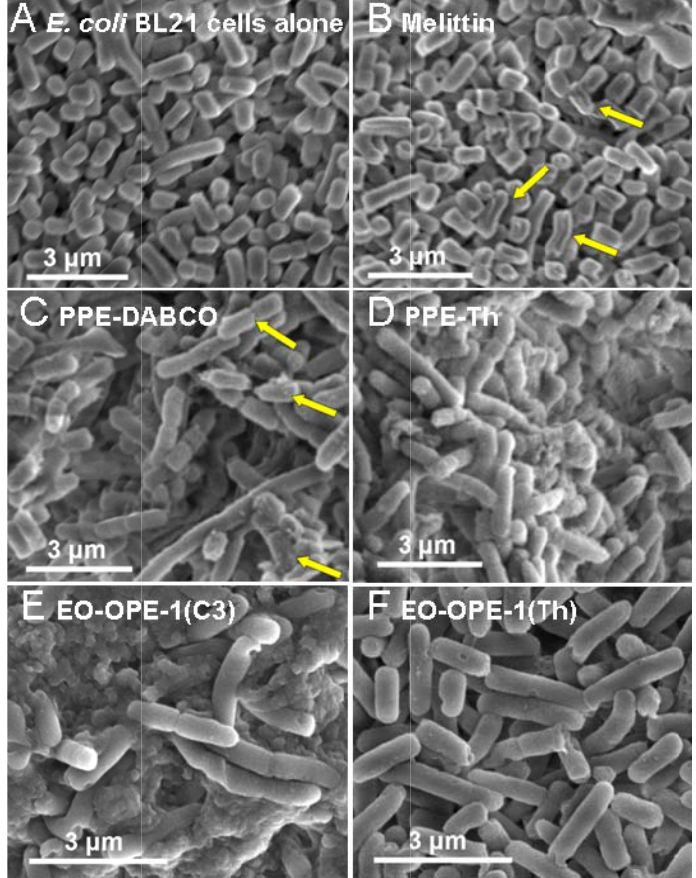
Figure e 4. SEM i 10 µg g/mL antimi image s are 3